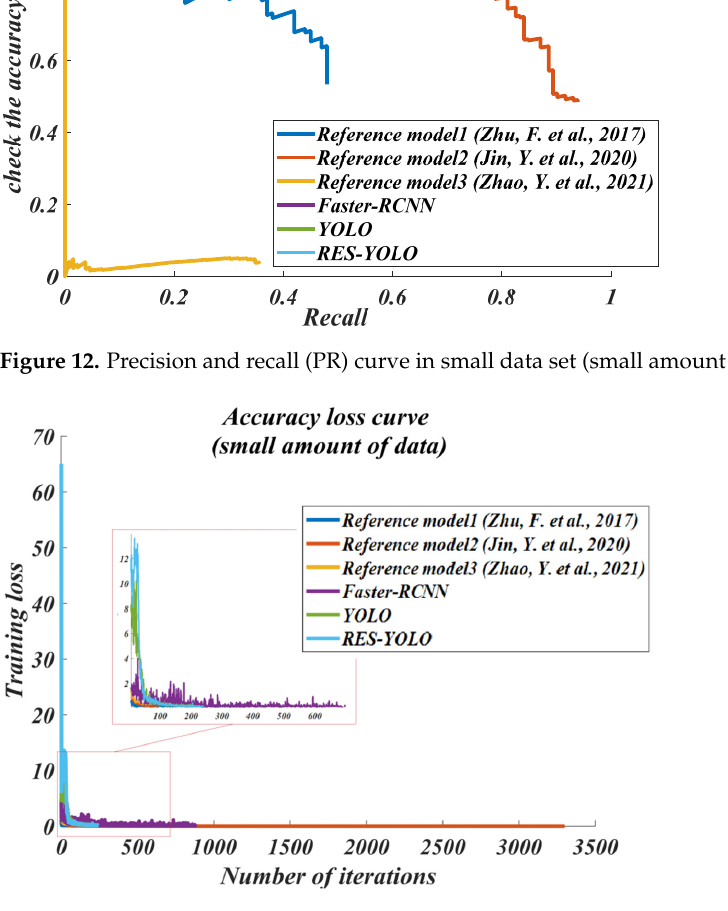
Figure 13. Accuracy–loss curve in small data set (small amount of data) [20–22].